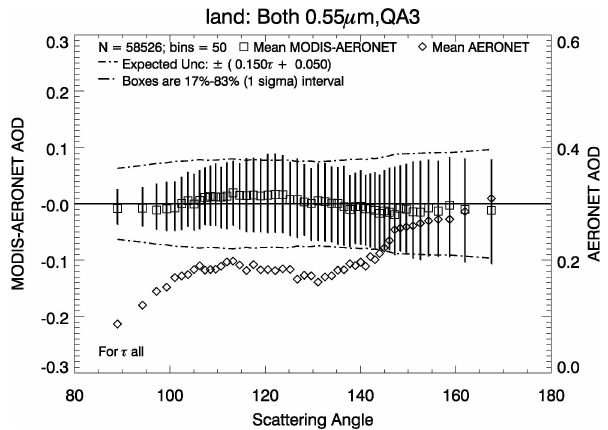
Fig. 11. Differences between MODIS and AERONET-reported AOD at 0.55µm (MODIS-AERONET) vs. MODIS -observed scat- tering angle, for QAC=3. The explanation of symbols is given in Fig. 6.